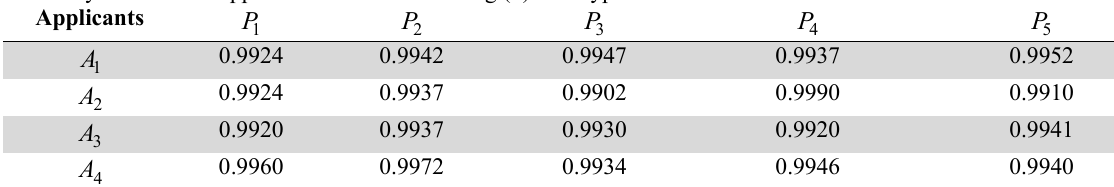
Similarity measure of Applicants vs. Positions using (7) and Type-1 score function